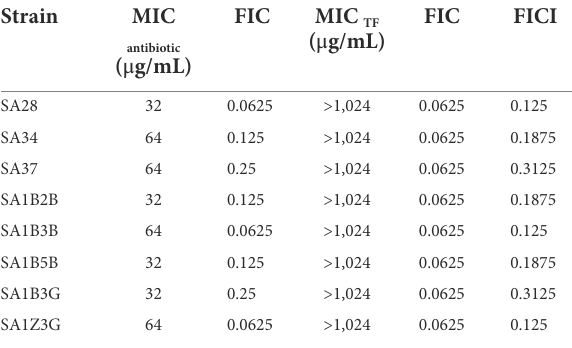
TABLE 3 Synergistic antibacterial effect of TF and ceftiofur against MRSA clinical isolates. Strain MIC antibiotic ( μ